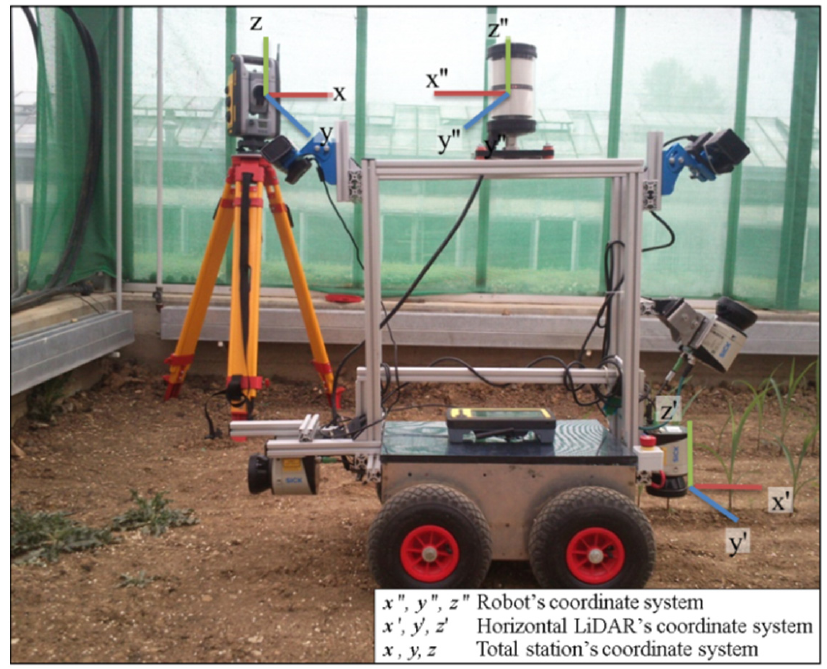
Figure 2. Robot’s (double quote), LiDAR’s (single quote), and total station’s (unquoted) coordinate systems.